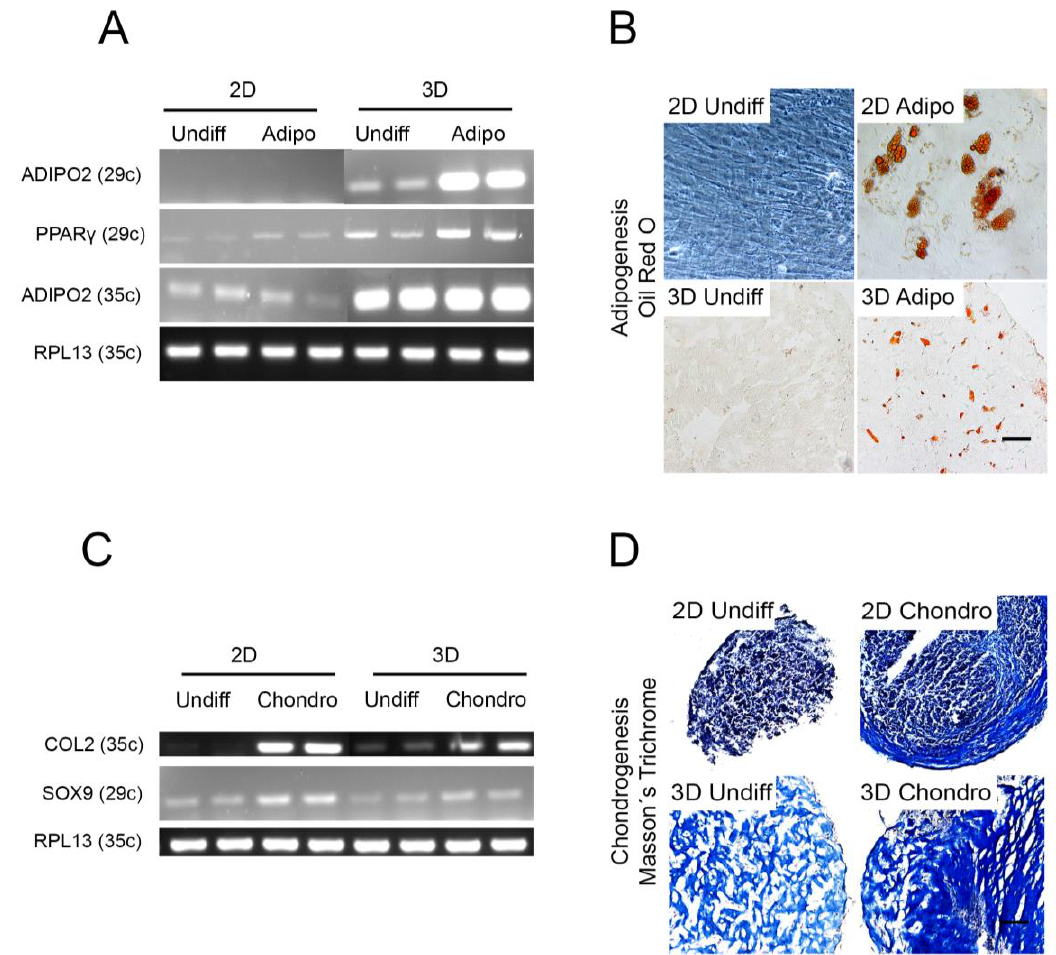
Figure 6. Adipogenic and chondrogenic differentiation in 2D and 3D. ( A , B ) BMSCs were cultured in four different conditions: 2D undifferentiated (2D undiff), 2D differentiated (2D diff), 3D undifferentiated (3D undiff), 3D differentiated (3D diff), in control or adipogenic medium for four weeks in 2D (adherent monocultures) or 3D (Col I gels, containing 3 × 10 5 cells per gel). ( A ) Agarose gel electrophoresis of semi-qt RT-PCR analysis of relevant adipogenic genes: ADIPO2 and PPAR γ at 29 and 35 amplification cycles (29c and 35c respectively). ( B ) Oil red O staining in 2D and 3D after adipogenic differentiation. ( C , D ) BMSCs were cultured in four different conditions: 2D undifferentiated (2D undiff), 2D differentiated (2D diff), 3D undifferentiated (3D undiff), 3D differentiated (3D diff), in control or chondrogenic medium for four weeks in 2D (pellet cultures) or 3D (Col I gels, containing 3 × 10 5 cells per gel). ( C ) Agarose gel electrophoresis of semi-qt RT-PCR analysis of relevant chondrogenic genes: COL2 and SOX9 at 29 and 35 amplification cycles (29c and 35c, respectively). ( D ) Masson ´ s trichrome staining in 2D and 3D after chondrogenic differentiation. Section thickness of 3D models = 12 µ m. Scale bar = 100 μm.